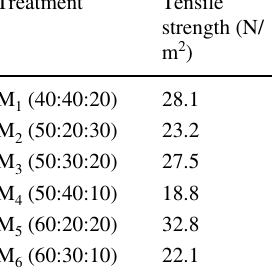
Table 2 The results of tensile strength analyses on composition treatment for organic mulch sheet